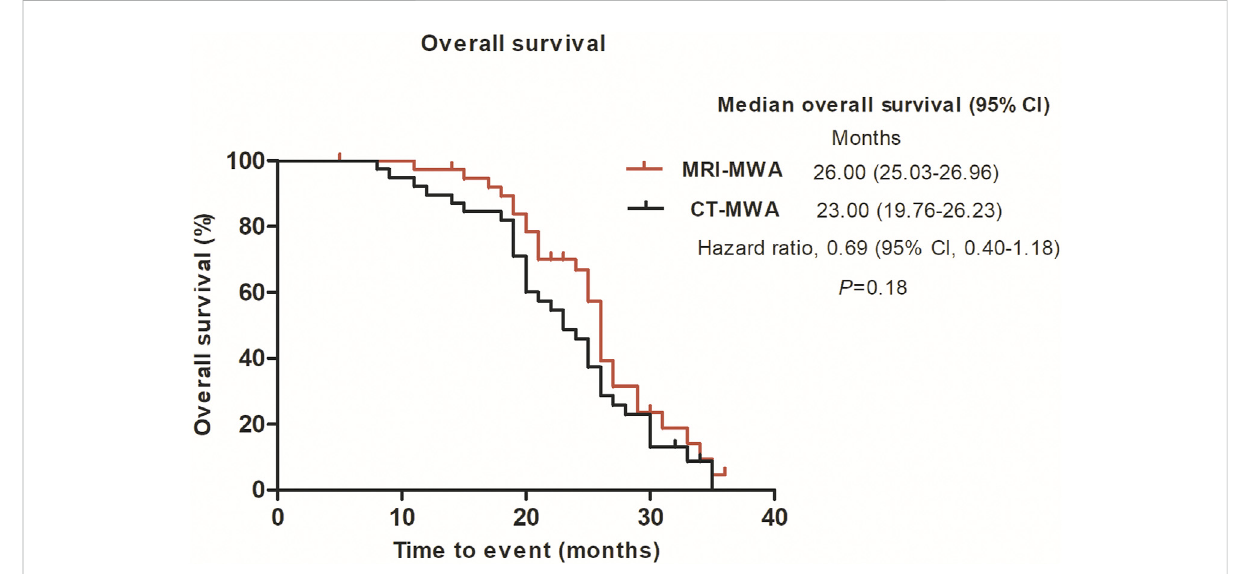
FIGURE 6 Graphs show Kaplan – Meier survival estimates for overall survival between MRI-MWA group and CT-MWA